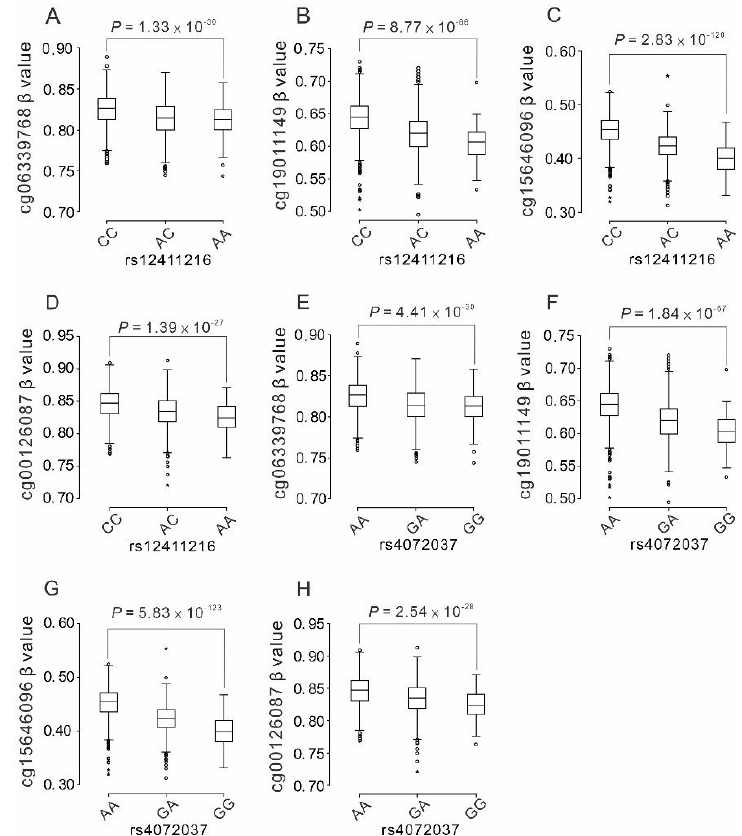
Figure 3. MUC1 gene-body DNA methylation levels according to MUC1 variants. The box-and-whisker plots are based on 1686 Taiwan Biobank participants with adjustment of age, sex, body mass index, and current smoking. The associations of cg06339768, cg19011149, cg15646096, and cg00126087 with rs12411216 genotypes ( A – D ) and with rs4072037 genotypes ( E – H ) are shown. o: β value < mean ± 3 standard deviation (SD), *: β value (cid:62) mean ± 3